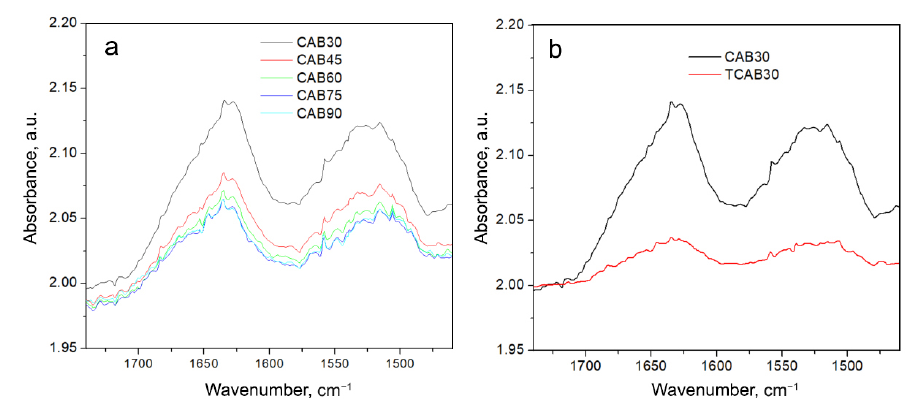
Figure 7. ( a ) Spectra of CAB recorded at different temperatures (from 30 to 90 ◦ C with a step of 15 ◦ C) in the region of Amide I and II vibrations. ( b ) Spectrum of CAB recorded at 30 ◦ C (black curve); spectrum of CAB obtained at 30 ◦ C after cooling from 90 ◦ C (red curve).